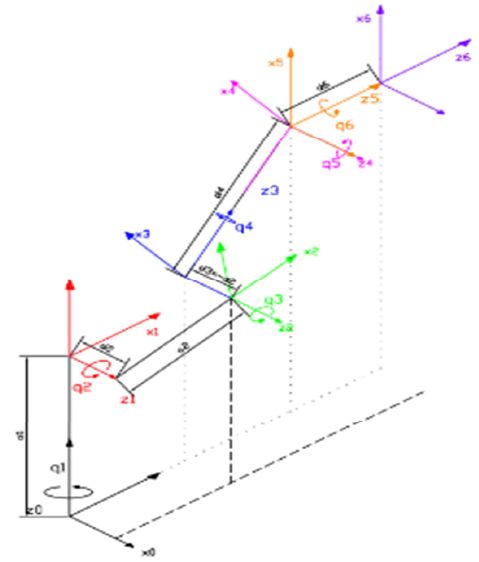
Fig. 6. The Attached Coordinate Frame Systems for EON Robot Model